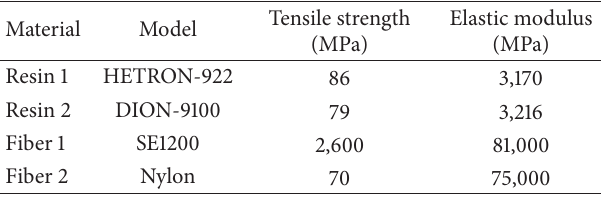
Table 1: Material properties of GFRP